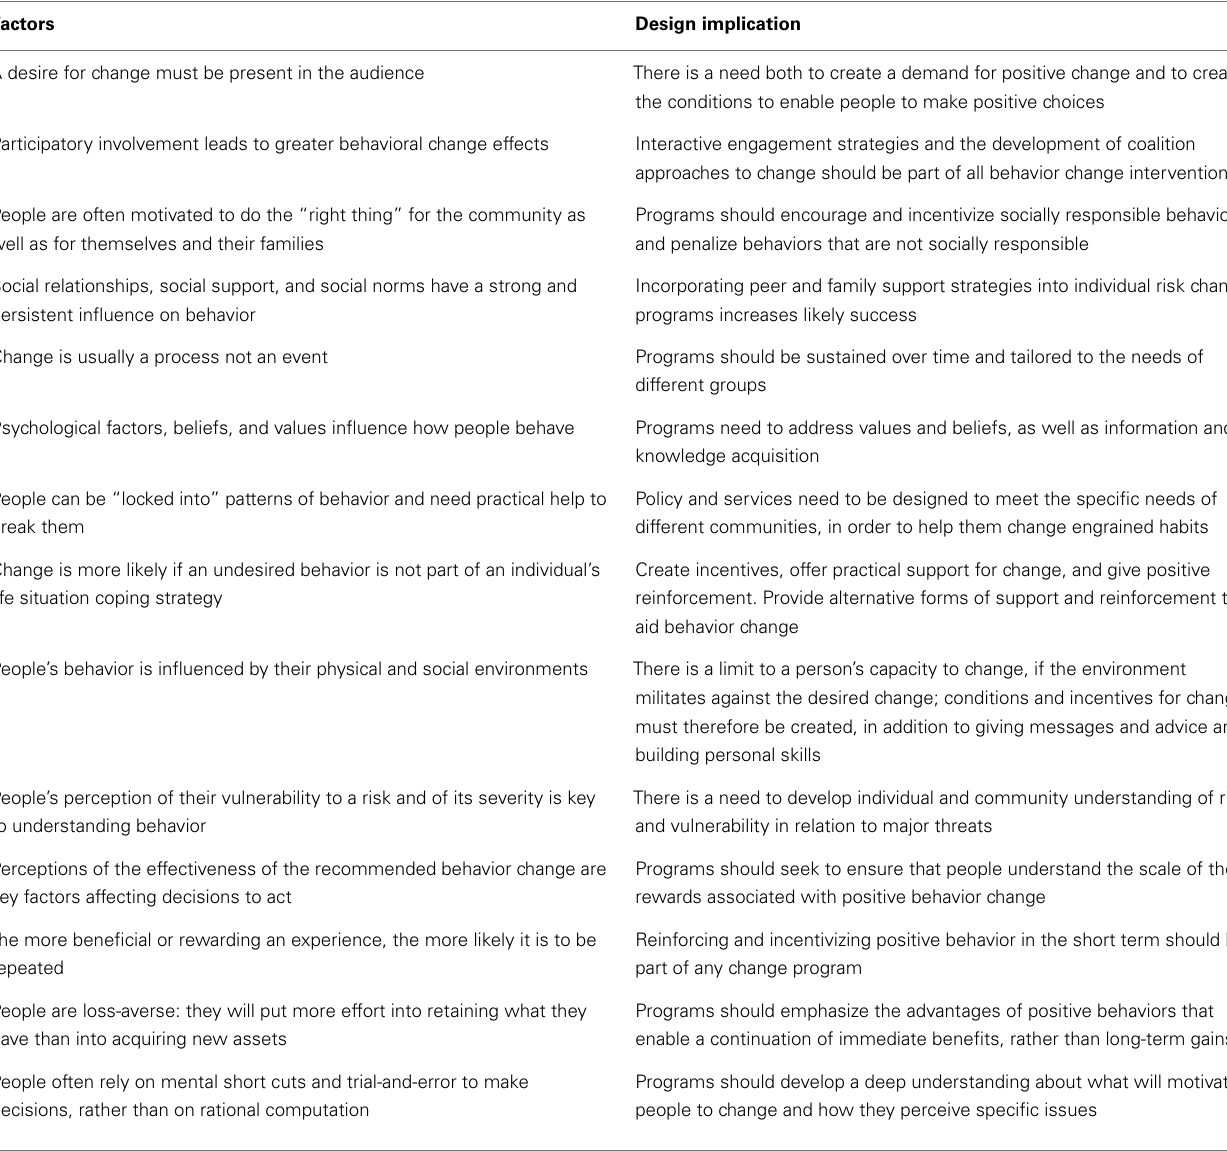
Table 3 | Common factors influencing behavior change and their implications for intervention design [adapted fromWHO European Ministerial Conference on Health Systems (28)]